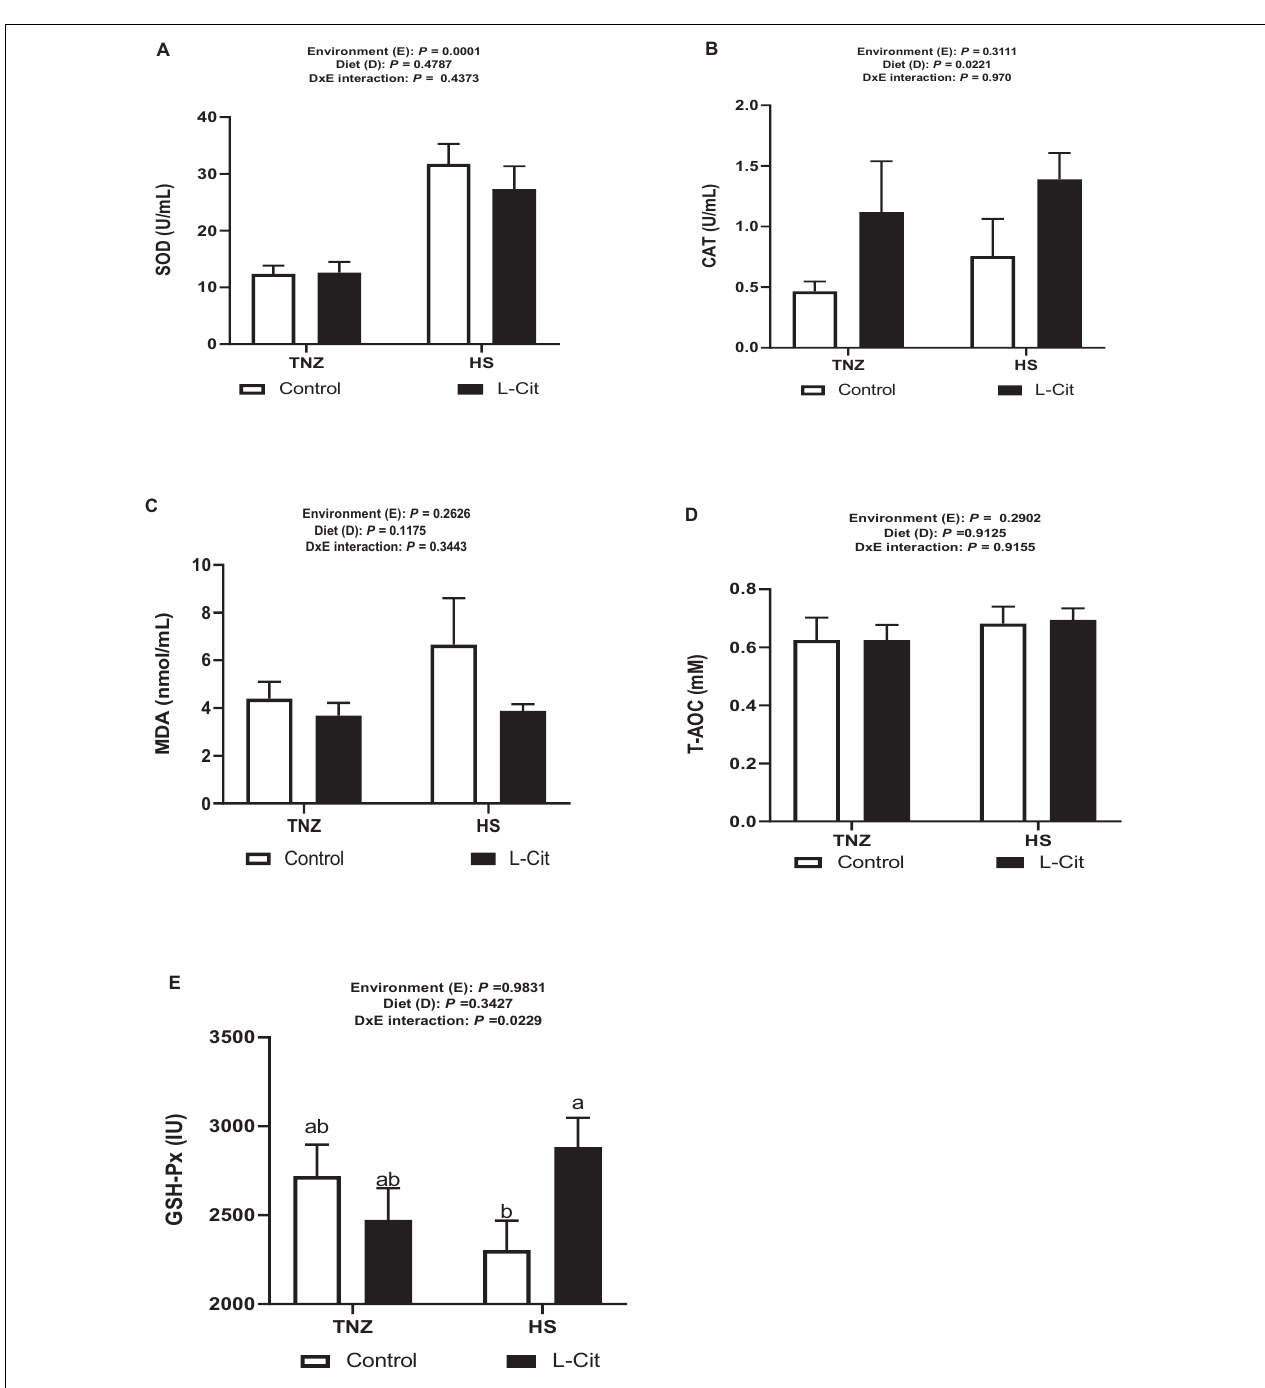
FIGURE 3 | L -Citrulline supplementation modulates the anti-oxidant properties of broilers during acute heat stress. (A) Superoxide dismutase (SOD) activity. (B) Catalase (CAT) activity. (C) Malondialdehyde (MDA) content. (D) Glutathione peroxidase (GSH-Px) activity. (E) Total anti-oxidant capacity (T-AOC). Data are presented as mean ± SEM ( n = 8). TNZ, thermoneutral; HS, heat stress. a , b Different letters indicate significant difference of D × E interaction at P < 0.05.